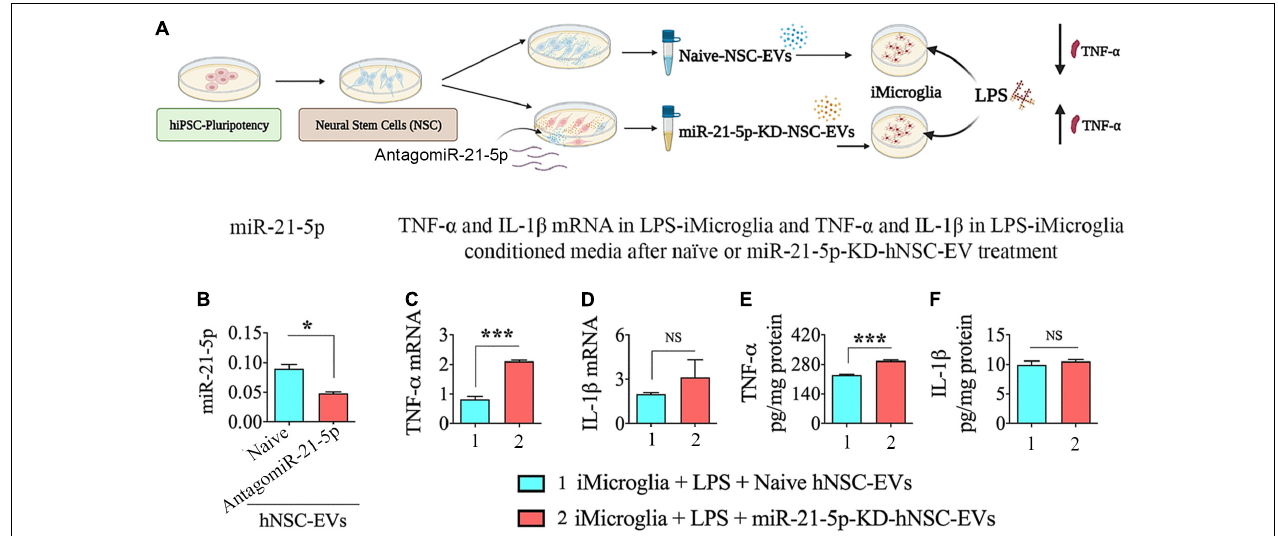
FIGURE 6 | Human neural stem cell-derived extracellular vesicle (hNSC-EVs) with reduced expression of miR-21-5p mediated diminished antiinflammatory activity on lipopolysaccharide (LPS) stimulated iMicroglia. (A) Is a schematic depicting the experimental design. The bar chart (B) shows the reduction in miR-21-5p content of hNSC-EVs (C) after antagomiR-21-5p treatment. The bar charts in (C,D) show that LPS-stimulated iMicroglia display enhanced expression of tumor necrosis factor-alpha (TNF- α ; C ) expression with no significant change in interleukin-1 beta (IL-1 β ; D ) mRNA expression when treated with hNSC-EVs with reduced expression of miR-21-5p (miR-21-5p-knockdown [KD]-hNSC-EVs), in comparison to naïve hNSC-EVs. The bar charts in (E,F) show that LPS-stimulated iMicroglia release a higher concentration of TNF- α (E) with no change in IL-1 β concentration (F) into the culture media when treated with hNSC-EVs with miR-21-5p-KD-hNSC-EVs, in comparison to naïve hNSC-EVs. * p < 0.05; *** p < 0.001; NS, not